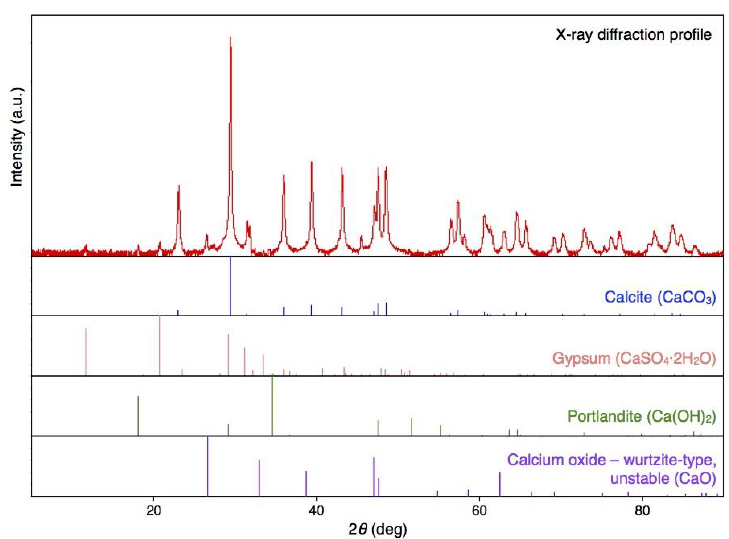
Figure 2. The CaCO 3 content of the white powder obtained upon air-drying of BiSCaO Water. X-ray diffraction demonstrated that the dry powder obtained from BiSCaO Water consisted primarily of CaCO 3 .